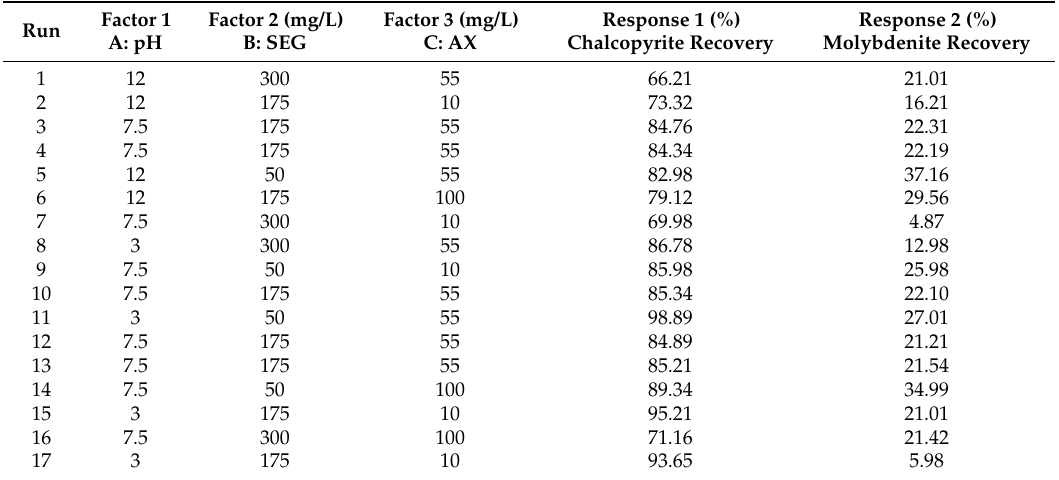
Table 2. The partially experimental design matrix as suggested by Design-Expert Software.